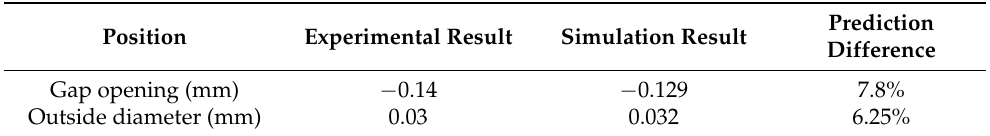
Table 3. Comparison of the experimental and simulated results for the geometric distortions of the